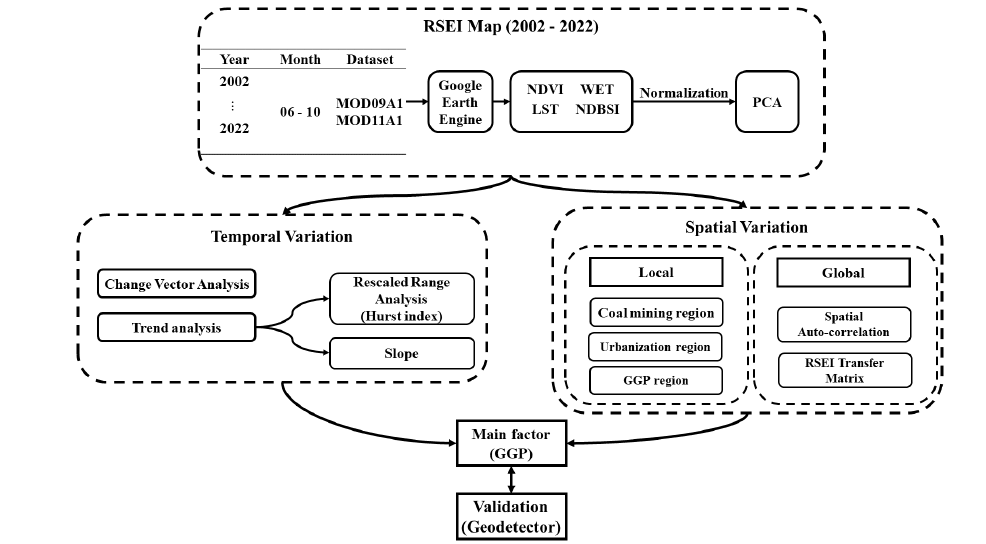
Figure 3. Analysis Framework of the RSEI in